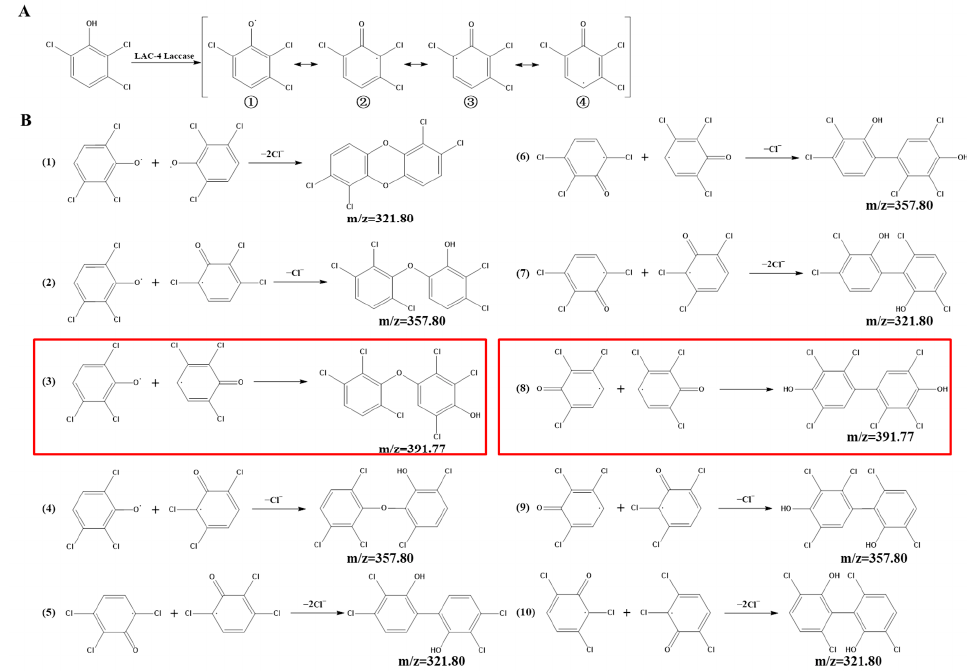
Figure 15. Free radicals generated by 2,3,6-TCP catalyzed by LAC-4 laccase ( A ) and the coupling reaction between the free radicals ( B ). 2,3,6-TCP was first oxidized by LAC-4 laccase, generating four chemically stable free radicals ( A , 1 (cid:13) – 4 (cid:13) ); then, ten possible coupling reactions randomly occurred between the free radical monomers ( B , (1)–(10)).